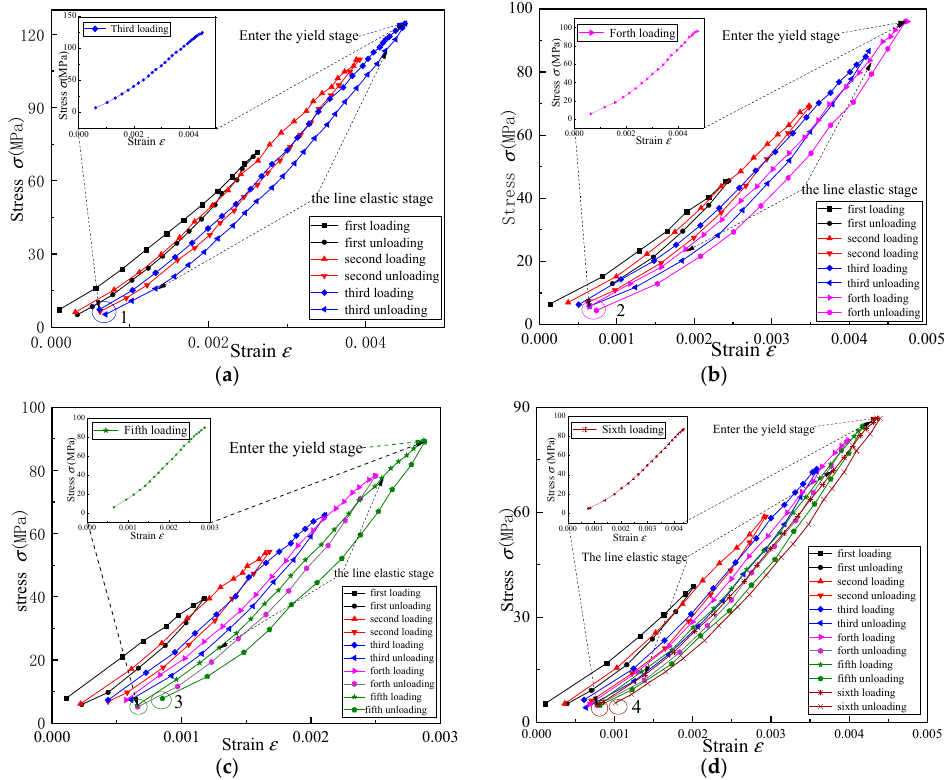
Figure 12. Plot of loading and unloading curves for the compression test from 0.043, 0.357, 0.625, and 0.754 levels of initial damage. ( a ) D = 0.043; ( b ) D = 0.357; ( c ) D = 0.625; ( d ) D = 0.754.